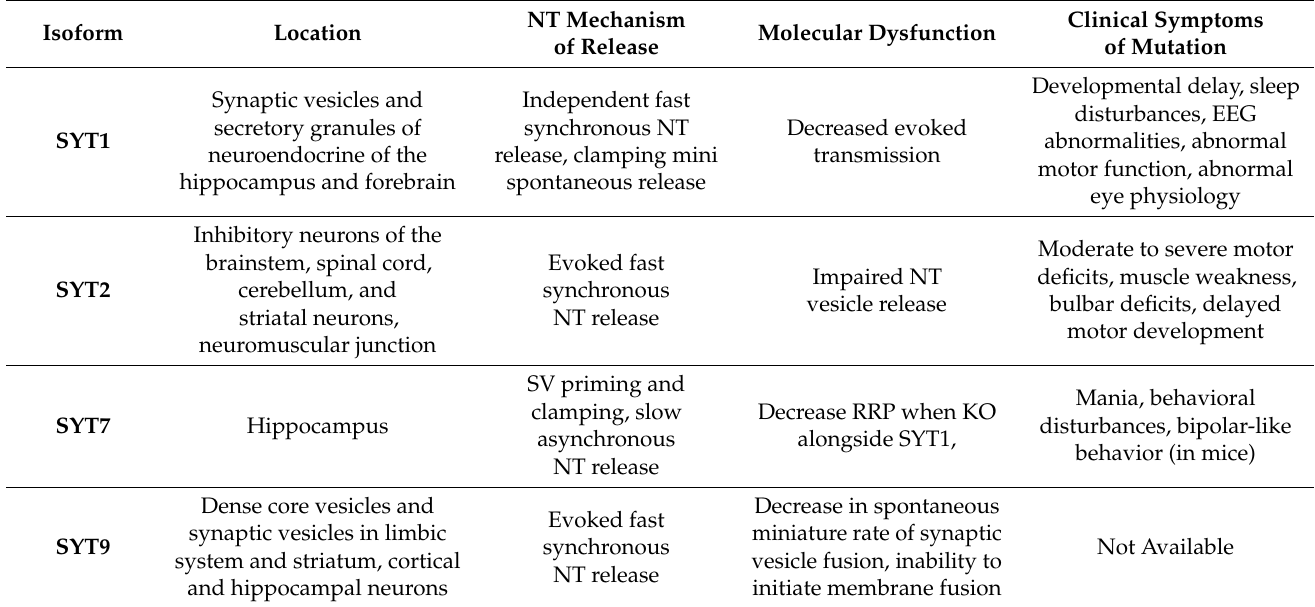
Table 1. Known Synaptotagmin Isoforms, Dysfunctions, and Clinical Mutations. Known synap- totagmin isoforms of clinical and functional relevance related to SYT1-associated neurodevel- opmental disorder, including their noted neurotransmitter mechanism of release and related molecular